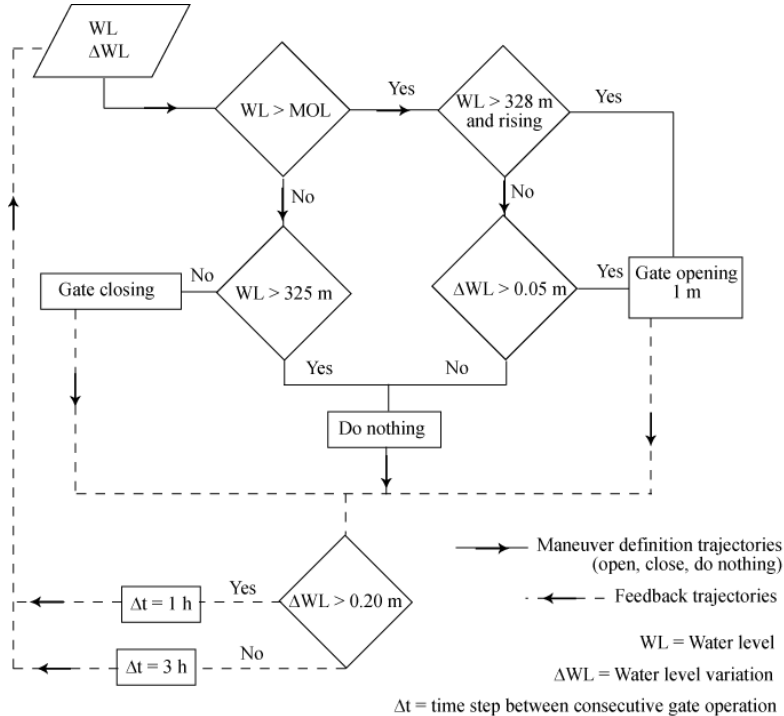
Figure 6. Flow chart that schematizes the functioning of the S2 operating rule.